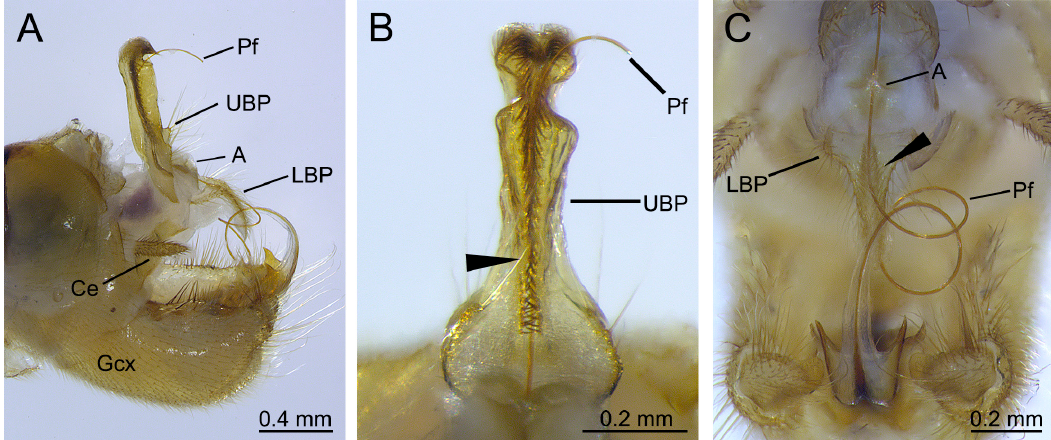
Figure 6. The penisfilum during Terrobittacus implicatus copulation, showing the pattern that the proctiger assists the penisfilum. ( A ) The penisfilum is meshed in the caudal groove of the proctiger. ( B ) The penisfilum is meshed in the groove of the upper branch of the proctiger. Arrowhead shows the dense short setae on the caudal groove. ( C ) The penisfilum is meshed in the groove of the lower branch of the proctiger. Arrowhead shows the dense short setae on the caudal groove. Abbreviations: A, anus; Ce, cercus; Gcx, gonocoxite; LBP, lower branch of proctiger; Pf, penisfilum; UBP, upper branch of proctiger.